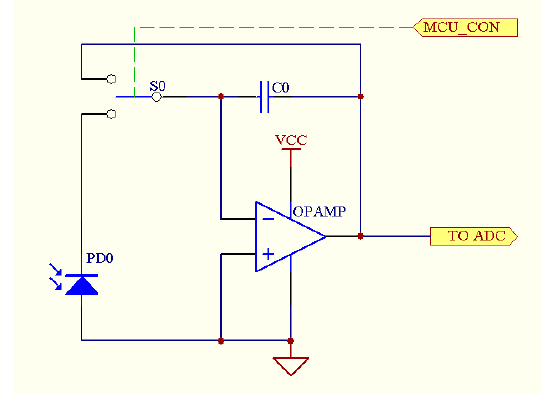
Figure 8. Integral-type signal processing circuit.